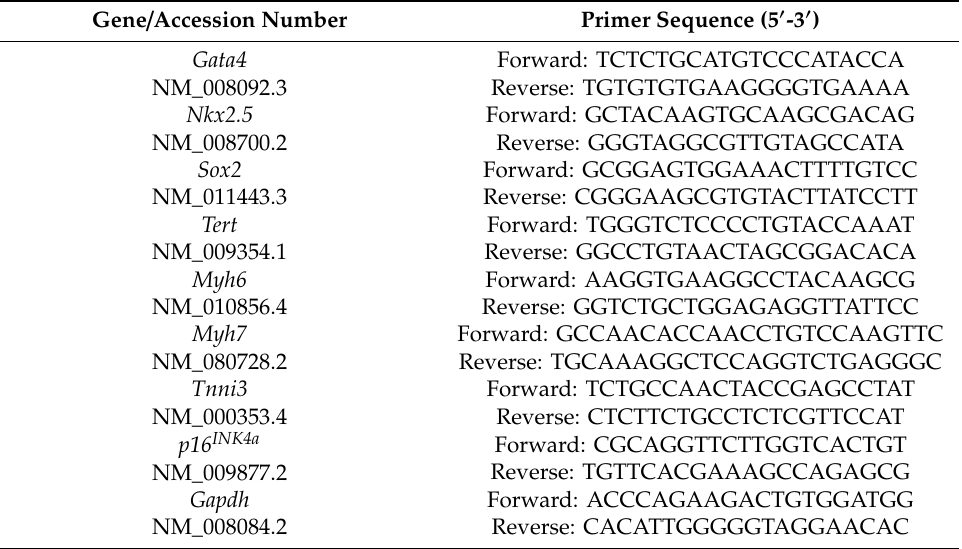
Table 2. Primer list used in this study.